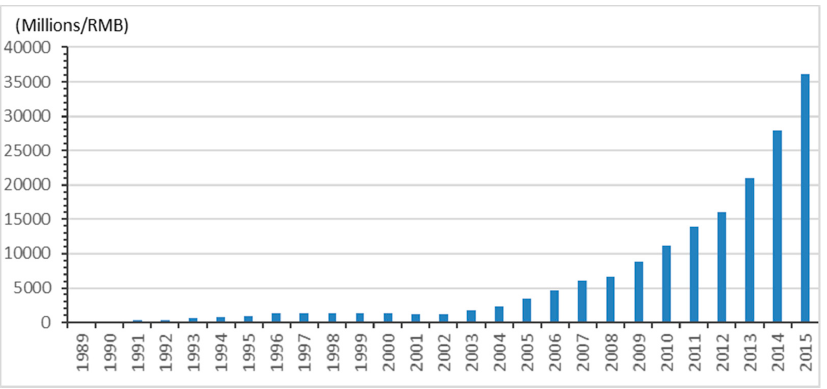
Figure 9. Fixed asset investment in Xishuangbanna from 1989 to 2015 (data from Yunnan Statistical